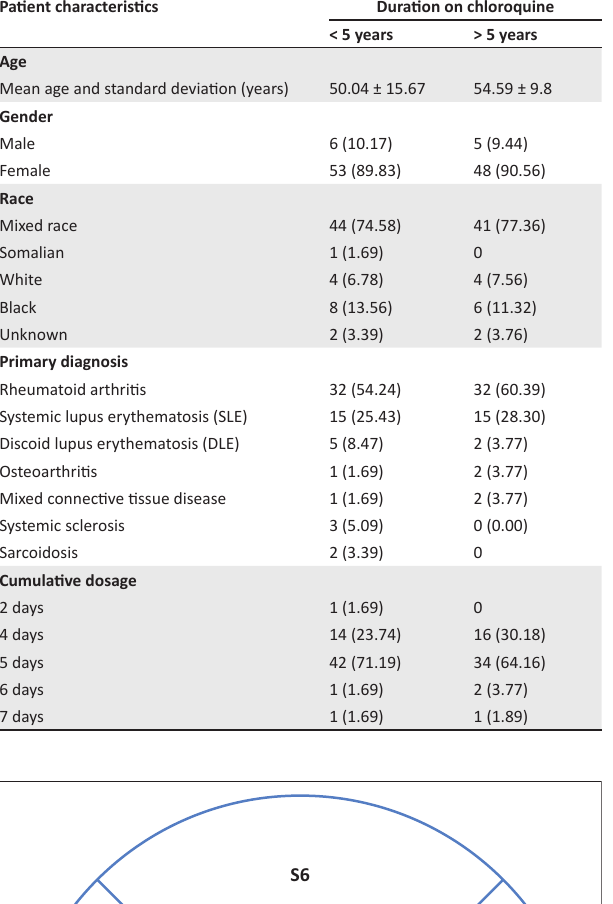
TABLE 1: Patient characteristics in Groups A and B using chloroquine for less than or more than 5 years. Patient characteristics